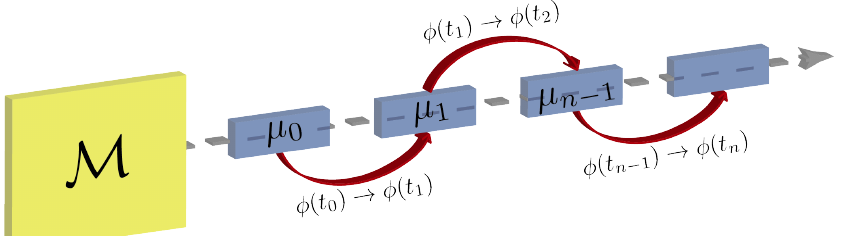
Figure 4. Graphical representation of the measurement schemes that lead to the evolution of the memory variable. Photon number measurements are performed on the environment, followed by a modification of phase φ depending on the averaged value of these measurements. In this figure, M represents the quantum memristor. Each individual experiment occurring at time t phase φ ( t k ) , is labeled by µ k , after which a value for the average number of output photons is obtained. This value is used to change the value of φ , from φ ( t k ) to φ ( t k + 1 )